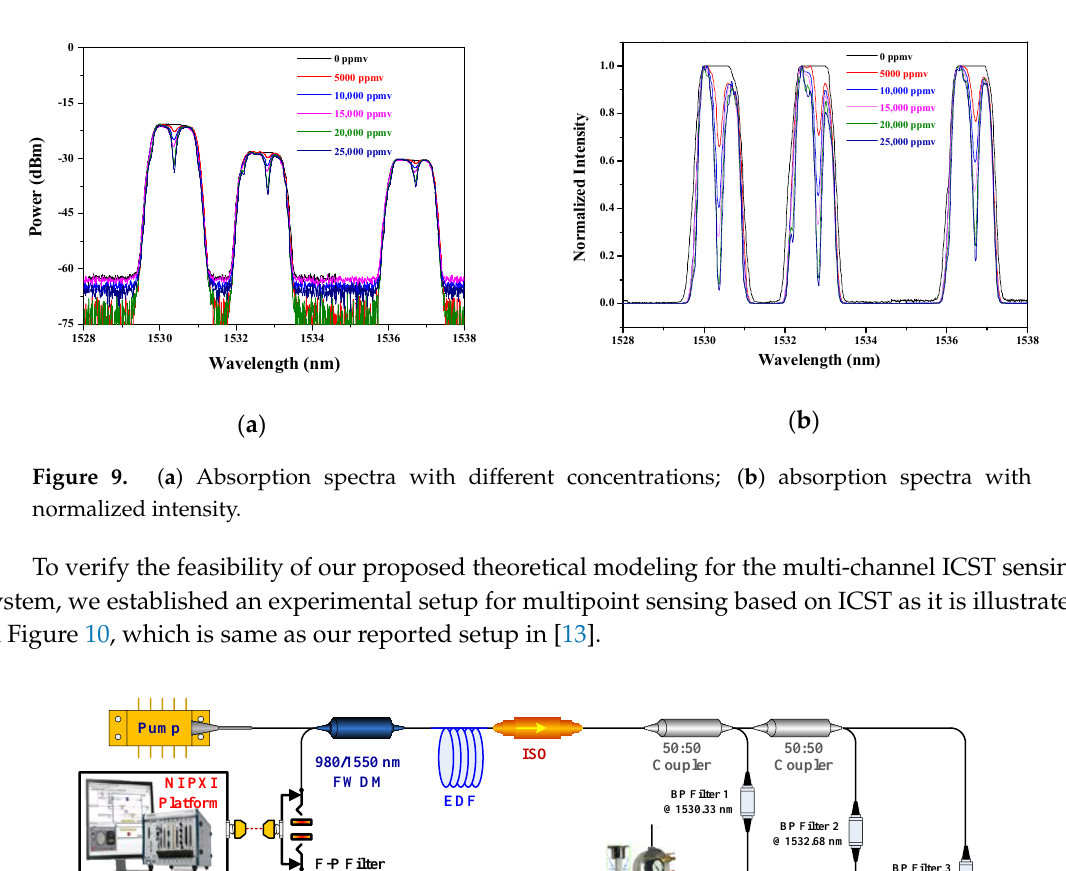
Figure 11. ( a ) Experimental absorption spectra with 10,000 ppmv C 2 H 2 ; ( b ) calculated absorption spectra with normalized intensity.